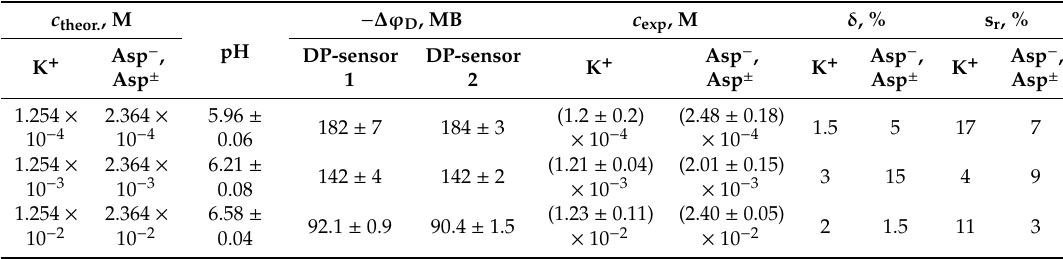
Table 5. The results of Asp − , Asp ± and K + ions determination in Panangin ® solutions ( n = 5, p = 0.95) using a multisensory system based on MF-4SC membranes containing 3 wt.% of SiO 2 with 10 mol.% of